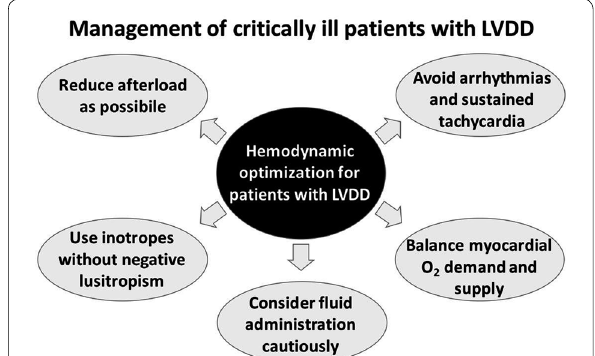
Fig. 3 Suggestions for the management of critically ill patients with left ventricular diastolic dysfunction